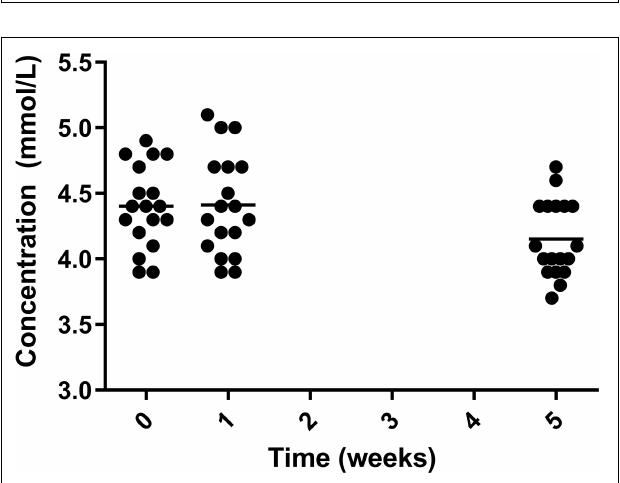
FIGURE 9 | Circulating potassium for the 19 participants who completed the study. The mean of each measurement shown as a solid black